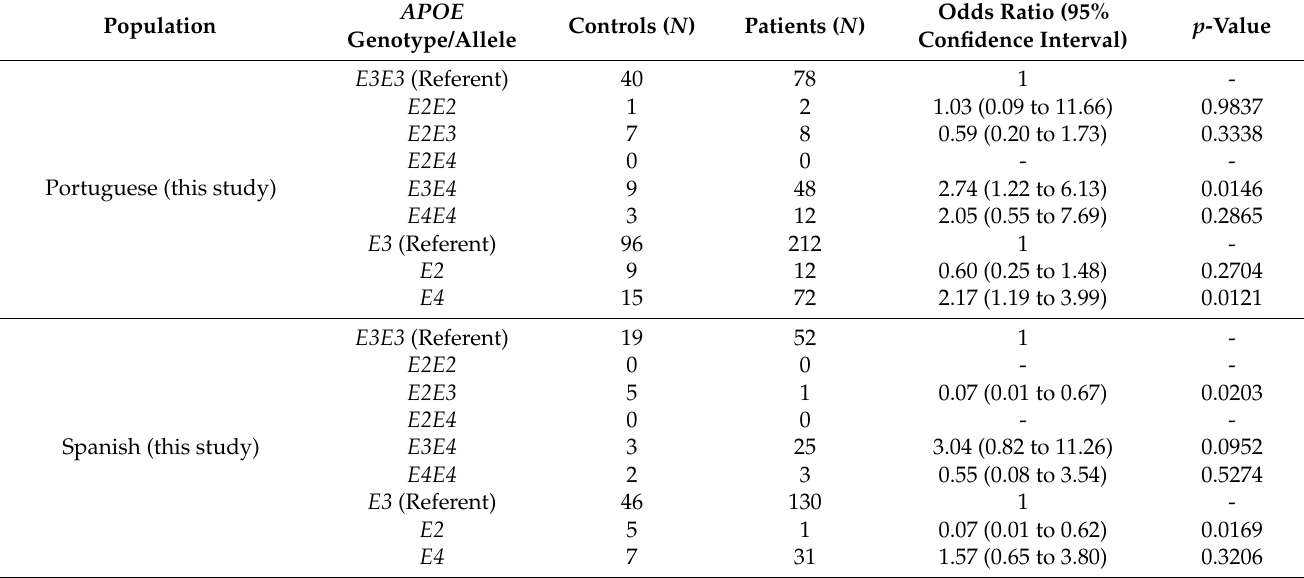
Table 4. Odds ratios of developing late onset Alzheimer’s disease according to Apolipoprotein E ( APOE ) genotypes and alleles among subjects from our Portuguese and Spanish cohorts in comparison to those calculated from reported APOE frequencies in a meta-analysis including several Caucasian populations (Farrer et al., 1997; [31]). N : Number of individuals or alleles when APOE genotypes or APOE alleles are analyzed,